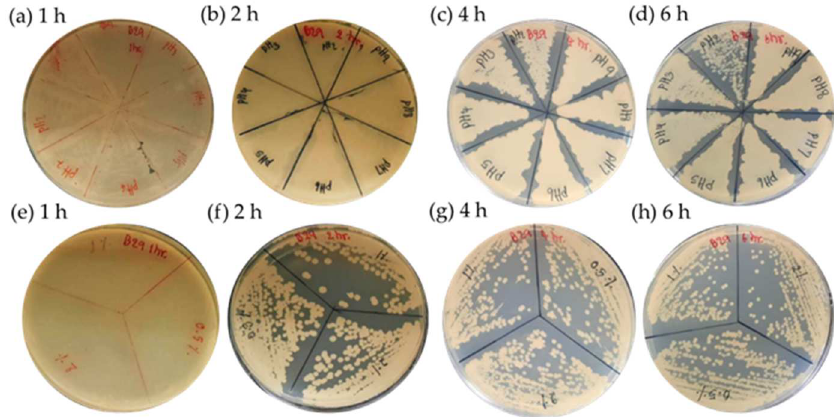
Figure 3. pH and bile salts tolerance test of Bacillus isolate B29; ( a – d ) pH tolerance test at pH 2–9; ( e – h ) bile salts tolerance test at 0.5%, 1%, and 2% for 1, 2, 4, and 6 h, respectively.